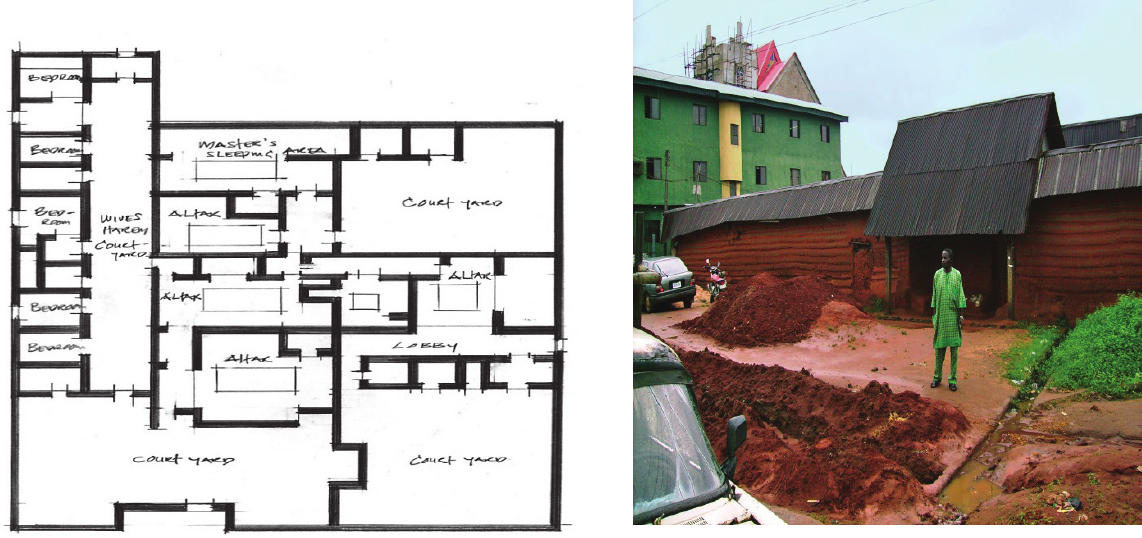
Fig. 3. Floor plan and picture of a typical palace-compound Benin house Source: Ekhaese